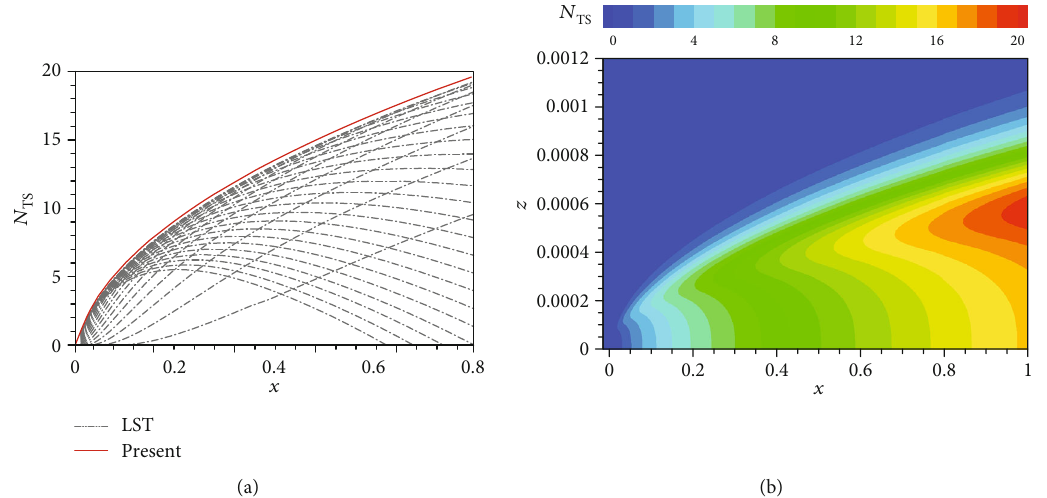
Figure 6: Predicted results of ampli fi cation factor. (a) Comparison with standard LST analysis results. (b) Contour at Mach number = 3 : 0 and Reynolds number = 5 : 6 × 10 7 /m